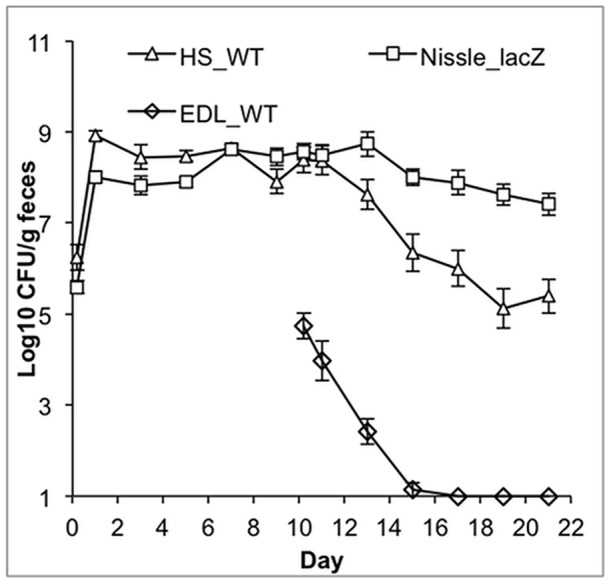
Mice precolonized with E. coli HS and E. coli Nissle 1917 prevent colonization by E. coli EDL 933.Mice were fed 105 CFU of E. coli HS StrRNalR and E. coli Nissle 1917 StrR ΔlacZ::cat. Ten days later, mice were fed 105 CFU E. coli EDL933. Data were collected as described in Figure 2.